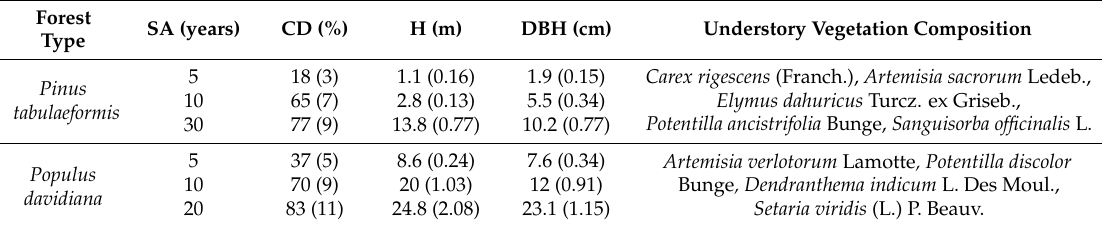
Table 1. The characteristics of plant communities in Pinus tabulaeformis and Populus davidiana plantations at three different stand